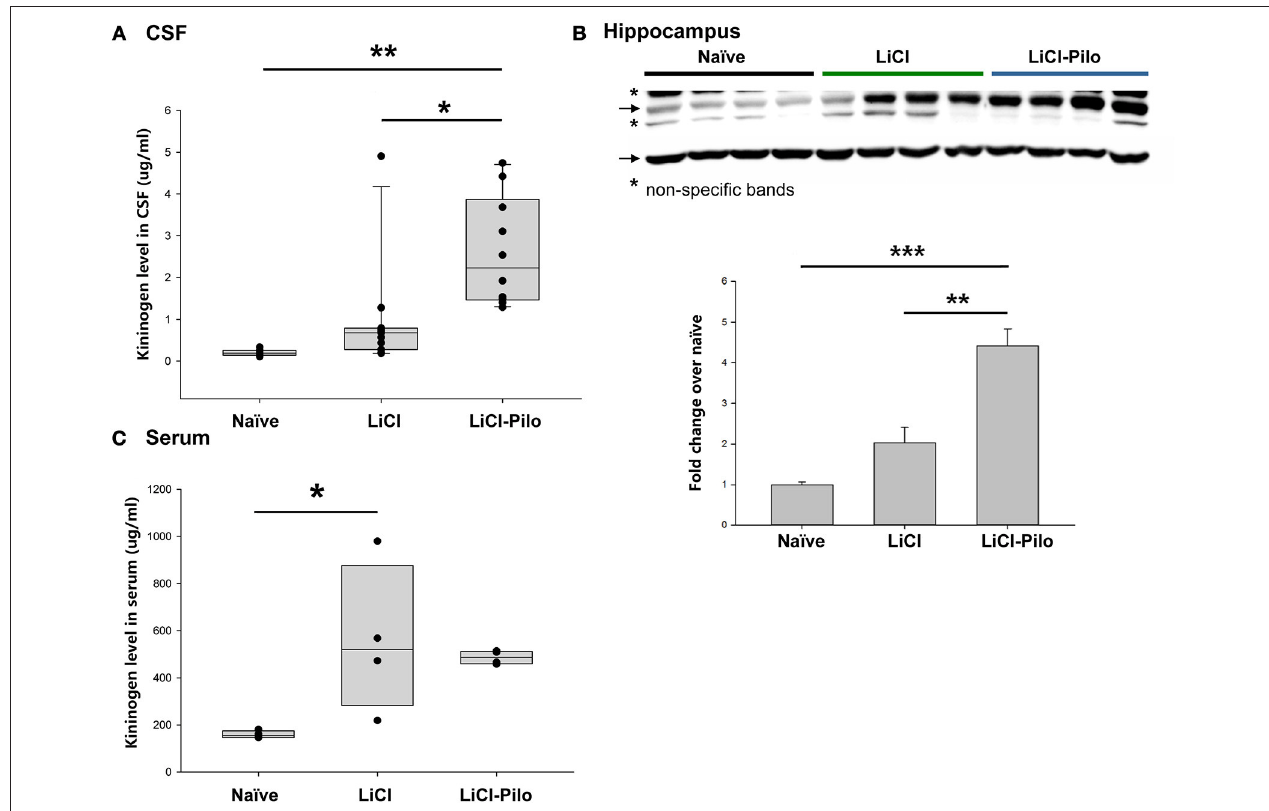
FIGURE 2 | Verification of the upregulation of KNG in CSF during early epileptogenesis. (A) The level of KNG in CSF using ELISA. (B) The level of KNG in the hippocampus using Western blotting. (C) The level of KNG in serum using ELISA. * p < 0.05, ** p < 0.01, *** p < 0.001.